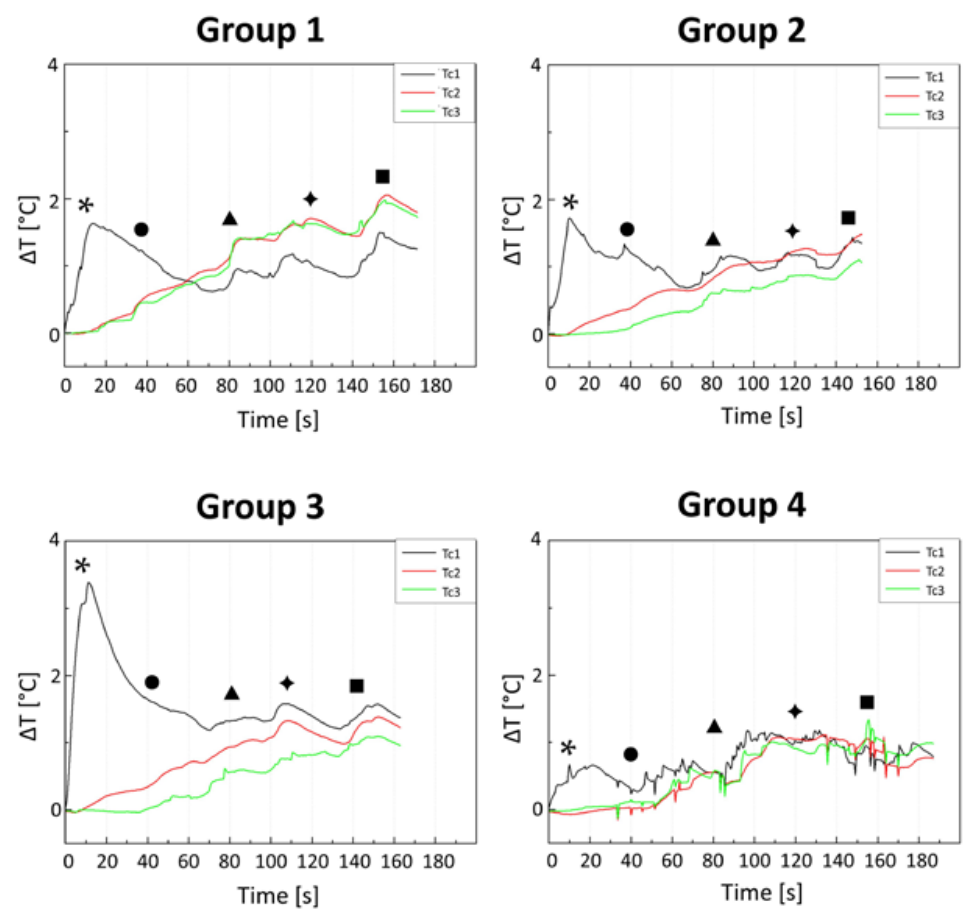
Figure 4. Mean temperature variation ( ∆ T) over time. The initiation of each drilling sequence step is indicated as follows: ( * ) Cortical Perforator drill; ( • ) 2.0 mm; ( (cid:78) ) 2.75 mm; ( (cid:70) ) 3.00 mm; ( (cid:4) ) 3.25 mm Figure 4 . Mean temperature variation ( ΔT) over time. The initiation of each drilling sequence step twist is indicated as follows: ( * ) Cortical Perforator drill; ( ● ) 2.0 mm; ( ▲ ) 2.75 mm; ( mm twist drills.